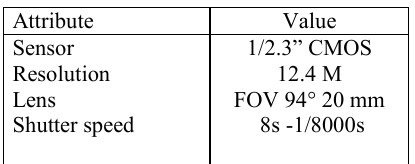
Table 1 Phantom 3 Pro camera properties